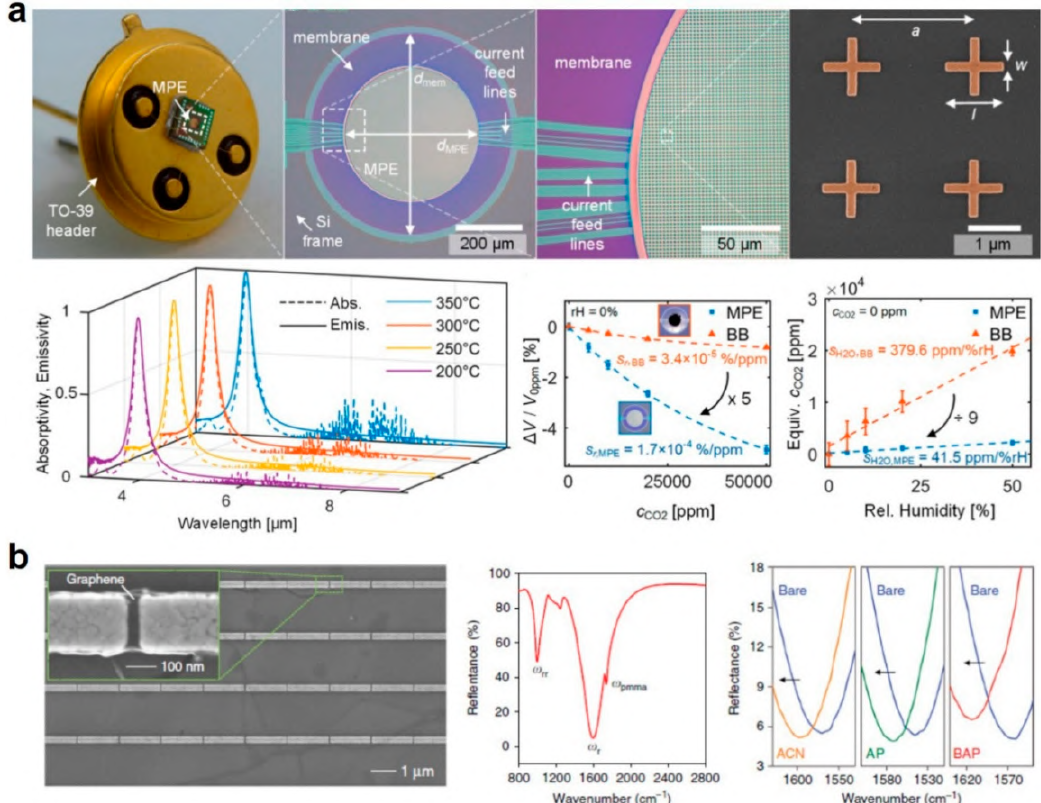
Figure 3. Thermal metamaterials for sensing. ( a ) Hierarchical structure of the infrared sensing device, experimental absorptivity and emissivity spectra at different temperatures, sensitivity characterization at various CO 2 concentration and humidity. Reproduced with permission from [91]. Copyright 2017, American Society of Chemistry. ( b ) SEM image of graphene-coated nanorod antennas, the reflectance spectrum, and the reflectance spectra before and after chemical functionalization. Reproduced with permission from [92]. Copyright 2017, American Society of